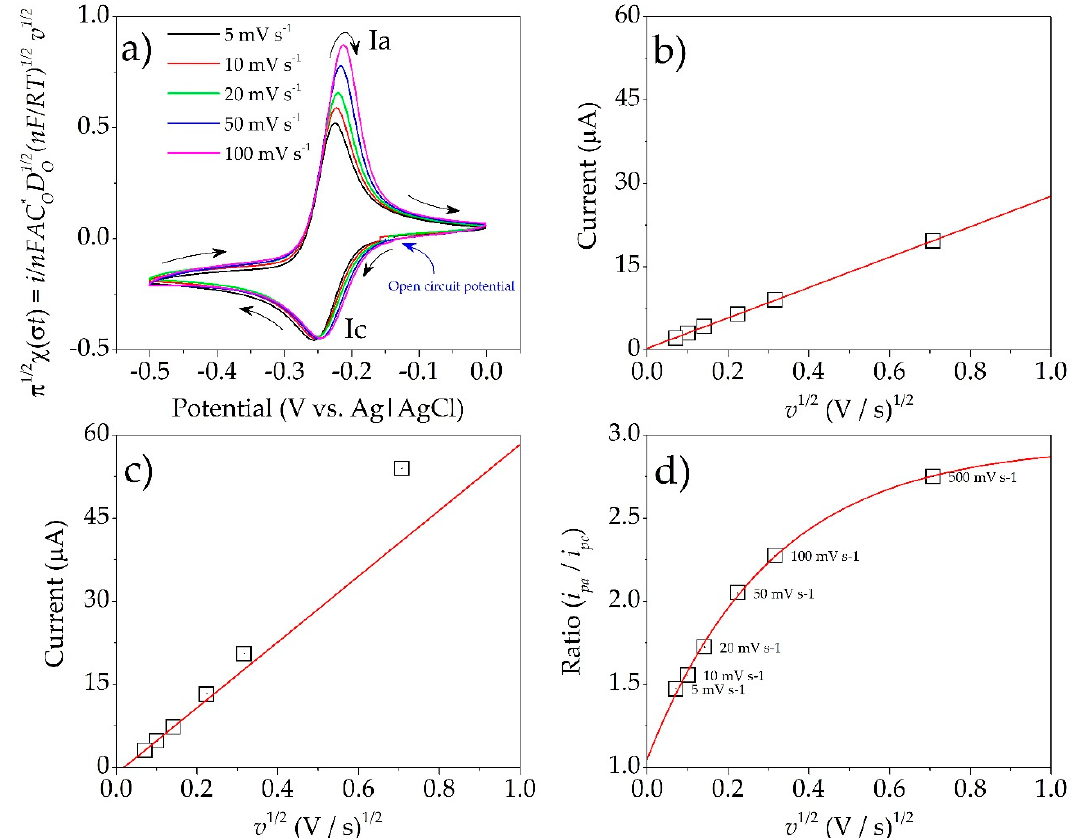
Figure 5. ( a ) Cyclic voltammetry of PYO (0.14 M) in current normalized at different scan rates ( v ). ( b ) i pc values for PYO (0.14 M) as a function of v 1 / 2 . ( c ) i pa values for PYO (0.14 M) as a function of v 1 / 2 . ( d ) i pa / i pc values of PYO (0.2 mM) as function of v 1 / 2 .